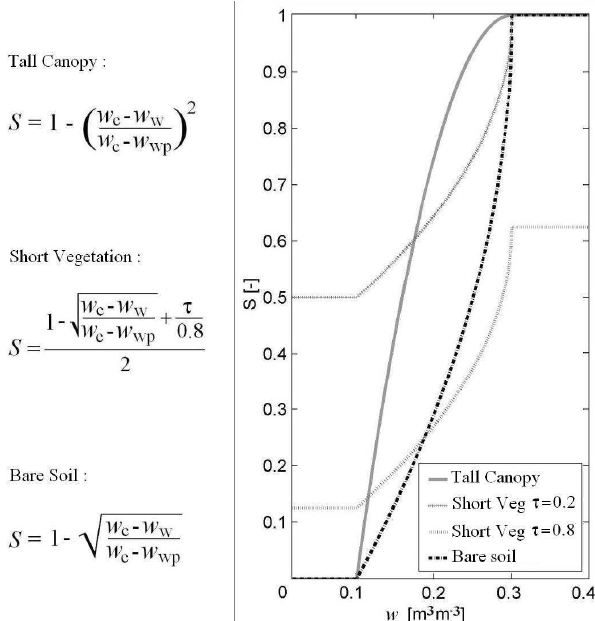
Fig. 3. Overview of stress parameterisations for tall canopy, short vegetation (at two levels of vegetation density: (a) τ = 0 . 2 , (b) τ = 0 . 8 ), and bare land. The values of w wp and w c are considered to be 0.1 and 0.3 m 3 m − 3 respectively; w w corresponds to the soil mois- ture modelled for the wettest